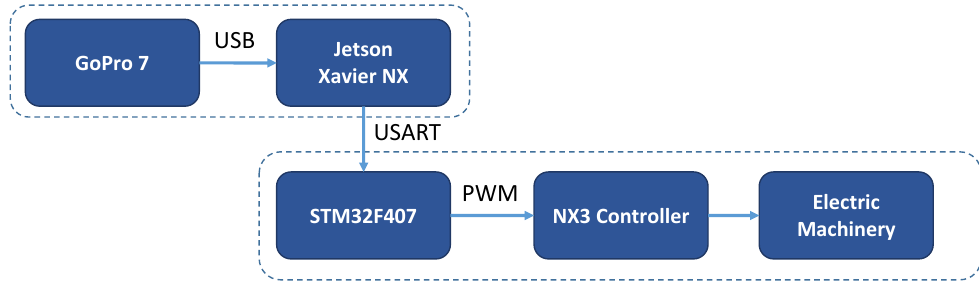
Figure 15. Hardware workflow.